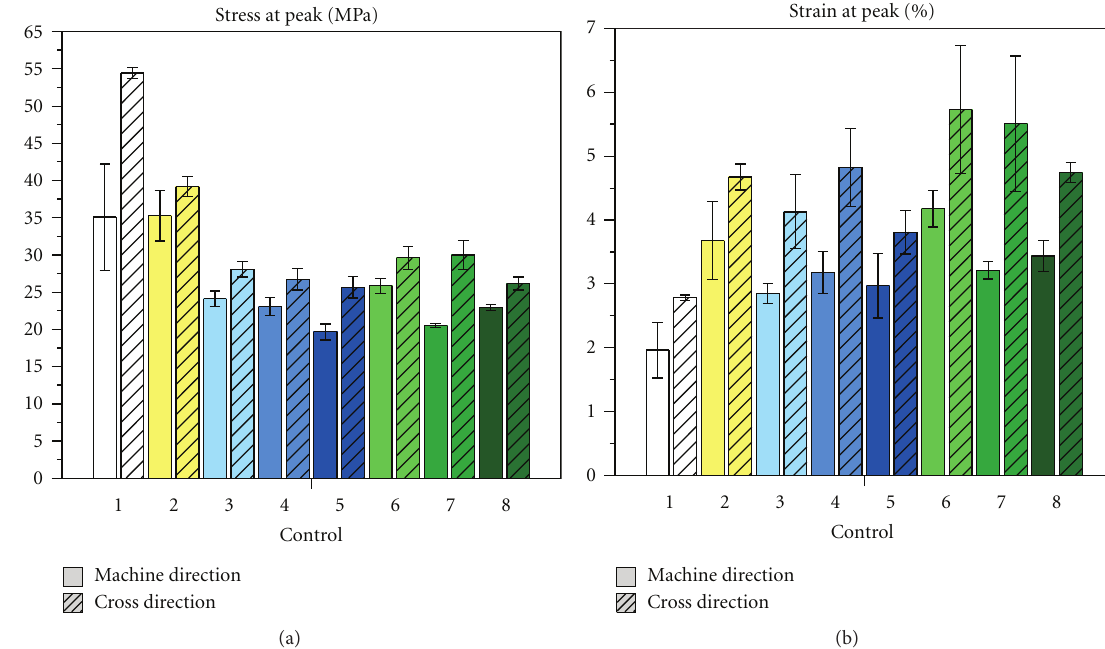
F 3: Stress at peak and strain at peak in machine and in cross directions.